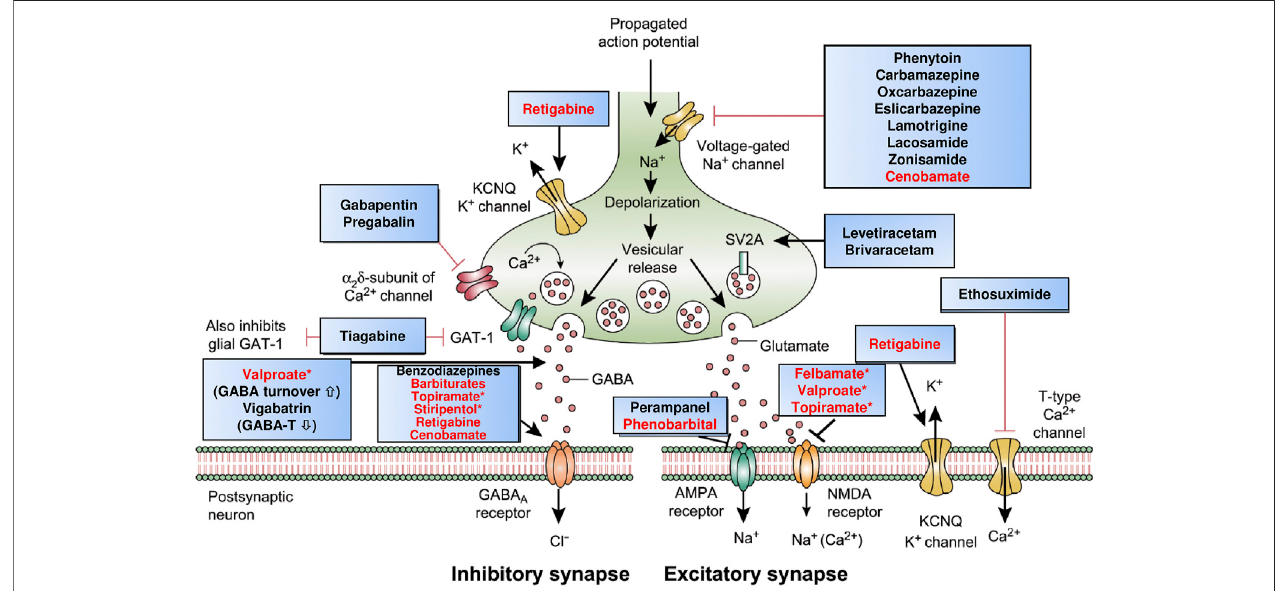
FIGURE 2 | Mechanism of action of clinically approved antiseizure medications (ASMs). Updated and modi fi ed from Löscher and Schmidt (2012), Löscher et al. (2016), and Löscher and Klein (2021b). Drug names highlighted in red indicate that these compounds act by multiple mechanisms; asterisks indicate that not all mechanisms are shown here. Note that several of the ASMs presumed to act by a single mechanism (e.g., phenytoin, carbamazepine, gabapentin) also possess other mechanisms (see Table 2 ). Some ASMs, e.g., fen fl uramine, are not shown here, but their mechanism(s) of action are described in Table 2 . Abbreviations: AMPA,